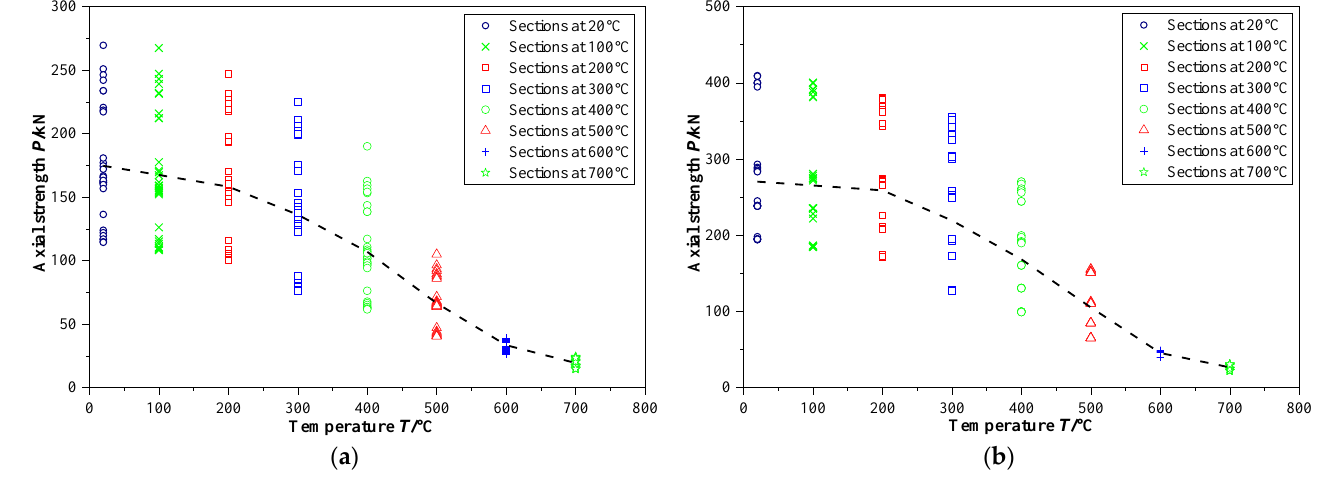
Figure 10. Influence of high temperatures ( T ): ( a ) CFS-FTF built-up unlipped channel columns at different temperatures; and ( b ) CFS-FTF built-up lipped channel columns at different temperatures.